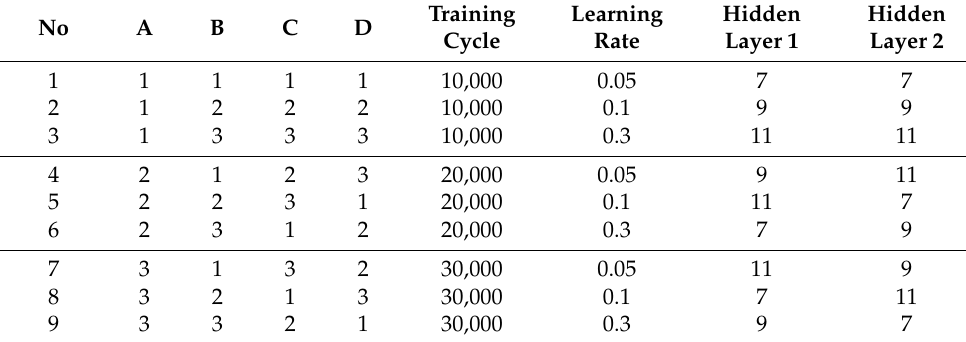
Table 13. L9 orthogonal table (CAE-1024).